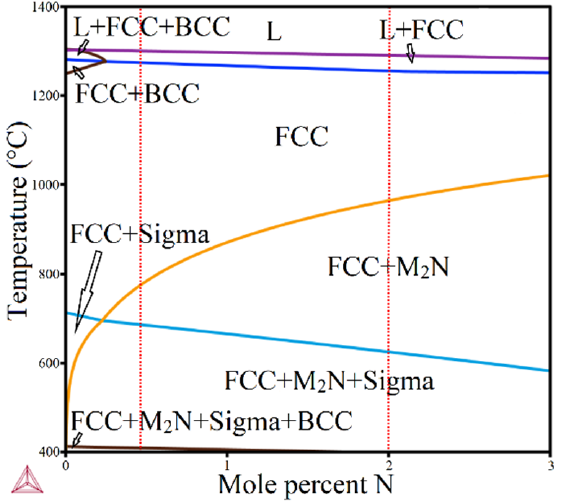
Figure 9. Equilibrium phase diagram produced by ThermoCalc software, showing the effect of nitrogen on the phase composition of the Fe 40 Mn 40 Co 10 Cr 10 alloy.